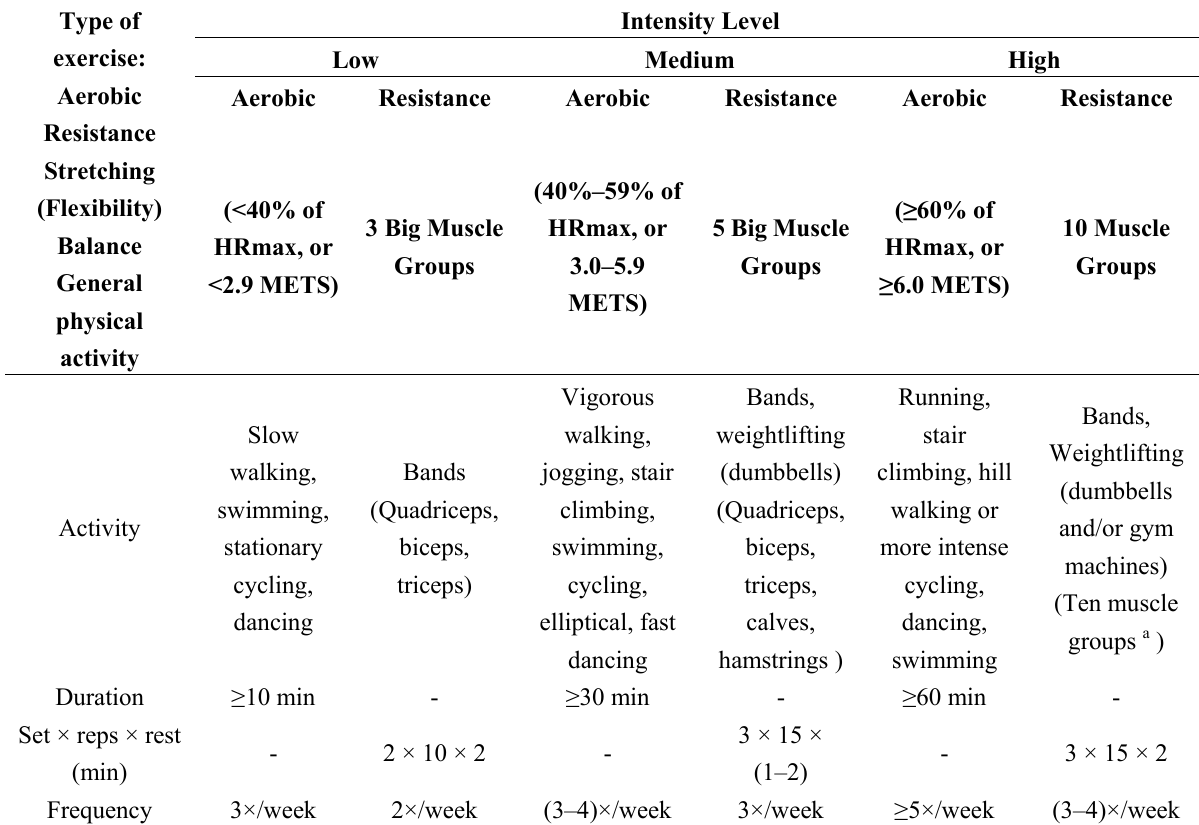
Table 7. Exercise prescription for individuals with diabetes and prediabetes with modifications for Venezuela. Adapted from